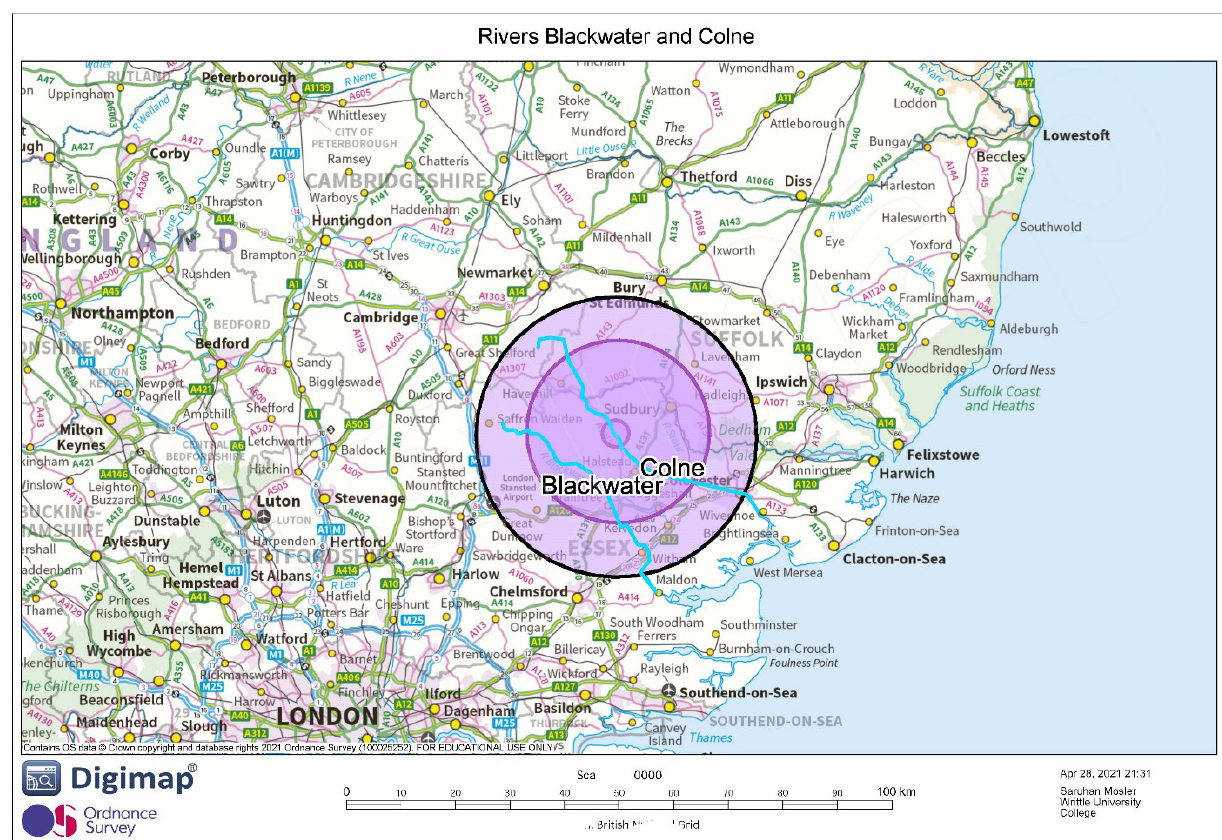
Figure 2. Rivers Blackwater and Colne in Essex. Source: Authors’ work, modified after Digimap (https://digimap.edina.ac.uk).